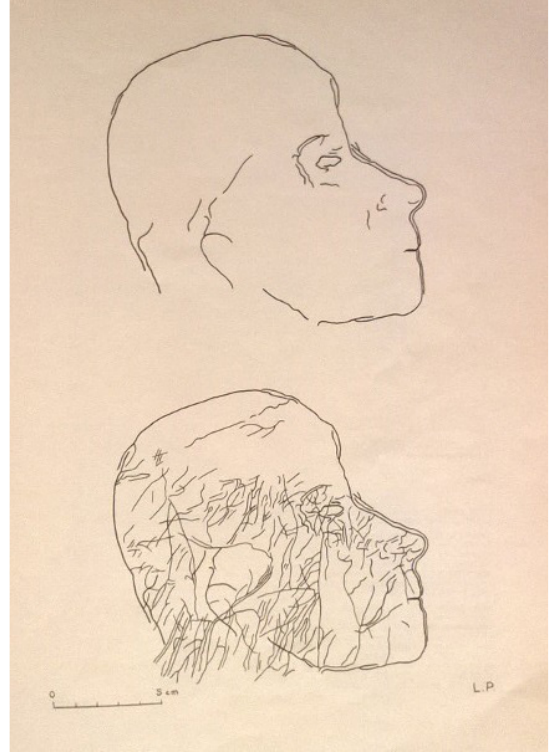
Figure 17. Group β, examples of Hand β1: Obs. 30(I) (from Pales,